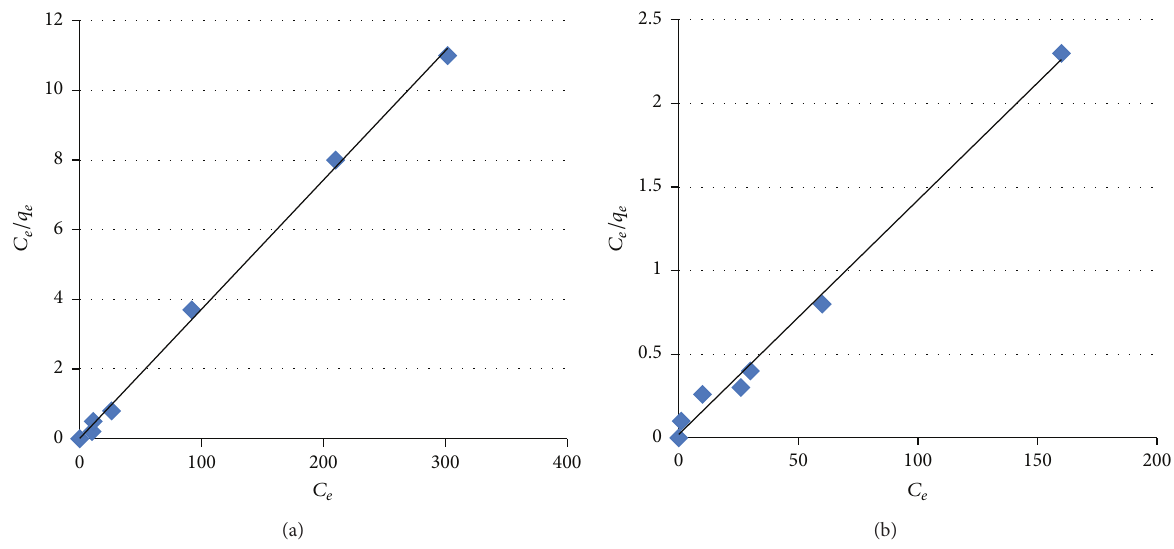
Figure 7: Langmuir adsorption model for (a) Fe/Pt bimetallic nanoparticles 25 ± 1 ∘ C and (b) resins at 35 ± 1 ∘ C.